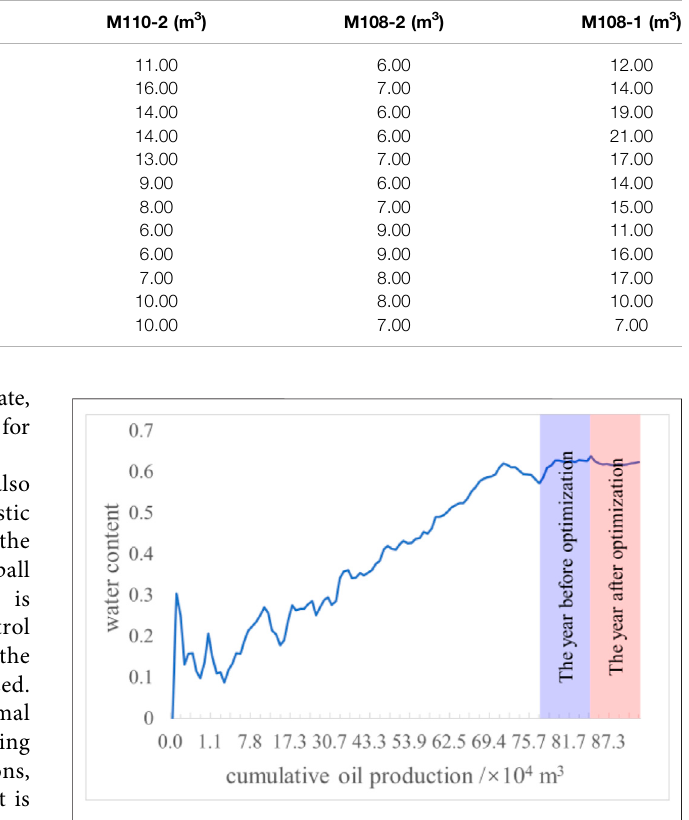
FIGURE 3 | Optimization